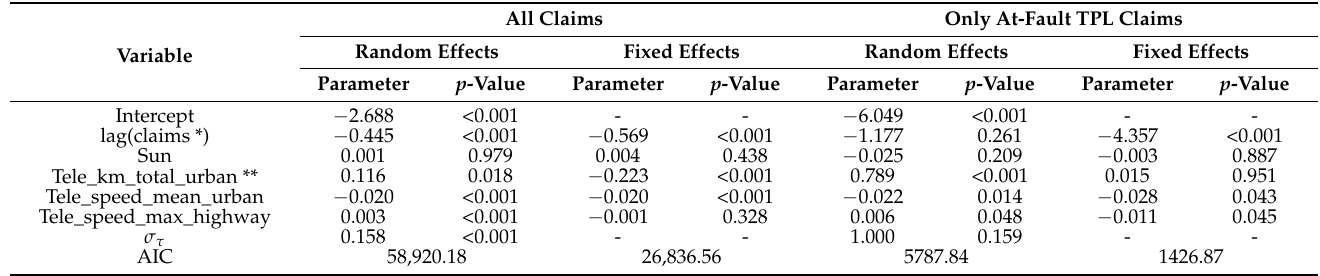
Table A2. Cross-table with the parameter estimates of random effects and fixed-effects Poisson panel data models, with p -values, for the total number of claims (left) and at-fault third-party liability (TPL) claims (right) per month and per insured based on the seven observed months in 2018 and 2019. The models consider the average number of sunshine hours per day as explanatory variable describing weather conditions.